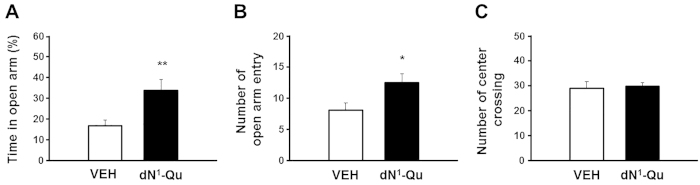
Administration of the GALR2 agonist dN1-Qu displays anxiolytic activity in animal models.Graphs show the % time in open arm (A), number of open arm entry (B) and center crossing (C). Data are presented as mean ± SEM (n = 9 for VEH and n = 8 for dN1, *p < 0.05 and **p < 0.01 versus VEH and dN1).